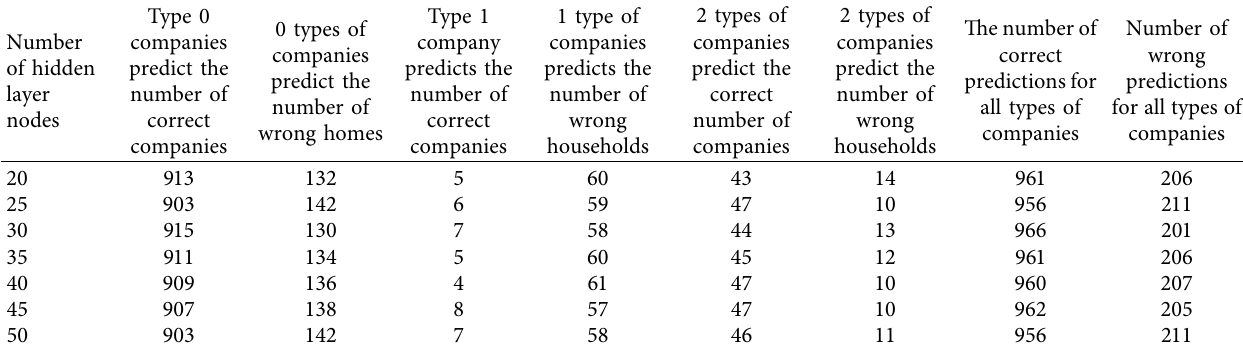
Table 5: BP network predicts the financial risk status of listed companies in 2010 (by the number of companies).